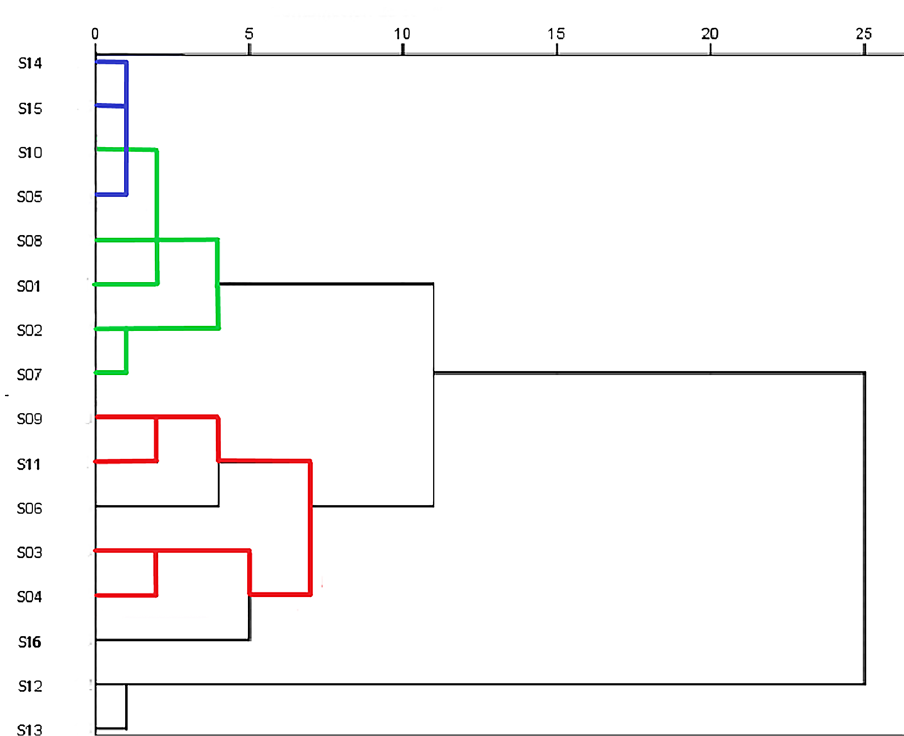
Figure 4. Ward method dendrogram. Combination of re-scaled distance clusters. Green lines indicate an instrumental view of nature, red lines indicate a conservationist view of nature, and blue lines indicate the environmentalist of the